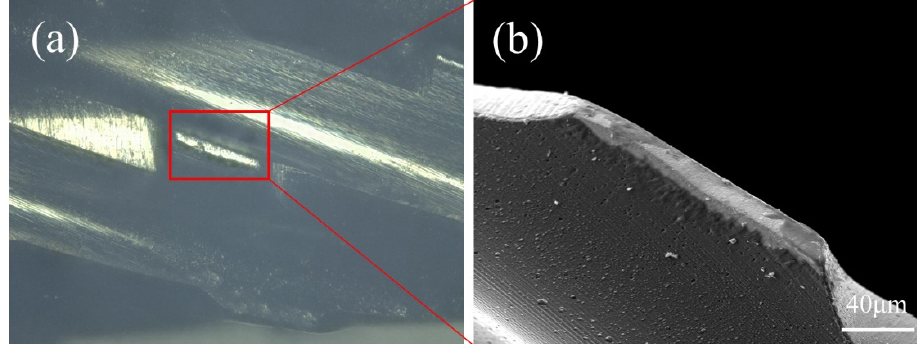
Figure 3. Wear of PCB tool: ( a ) PCB tools; ( b ) Local zoom.